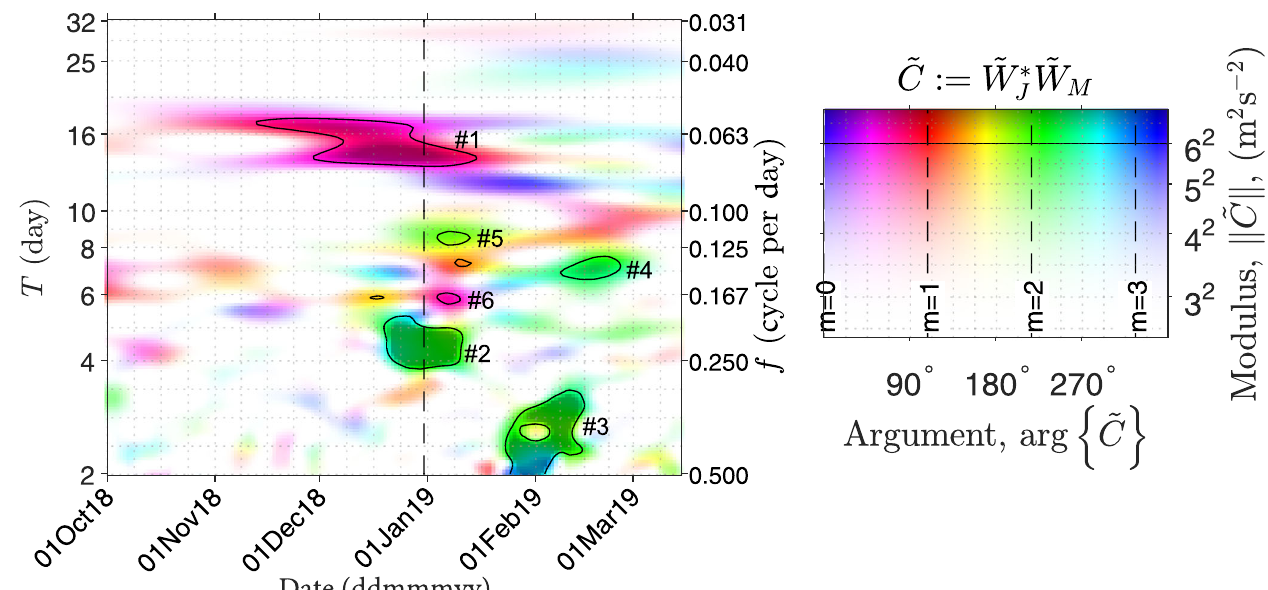
Fig. 2 | Altitude-averaged (80 – 96 km) cross-wavelet spectrum of horizontal windbetweenMohe(122 ∘ E,54 ∘ N)andJuliusruh(13 ∘ E,55 ∘ N). Averaged here is the sum of the spectrum of zonal wind u and that of the meridional wind v . The darkness and color hue in each panel denote the modulus and argument of the spectrum, namely, k ~ C k and arg f ~ C g , respectively. The phase is a function of zonal wavenumber m as speci fi ed in the color code. The six numbers following